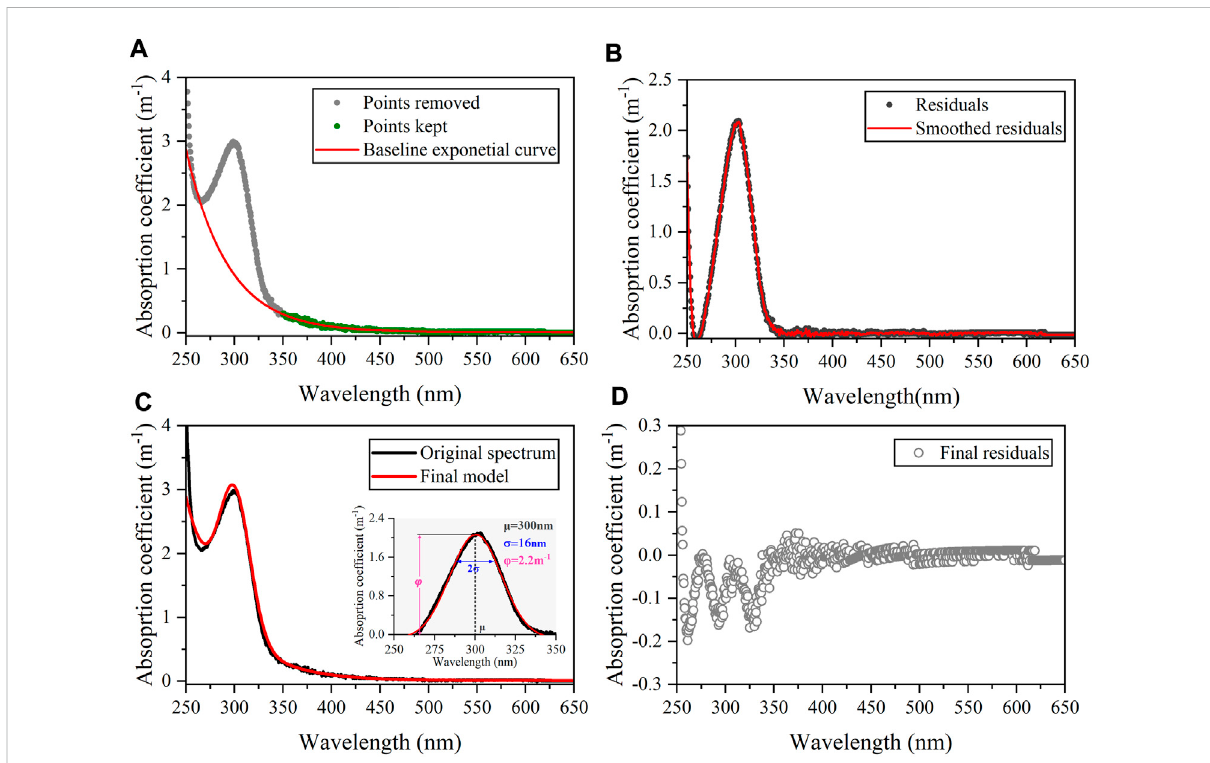
FIGURE 6 Schema of the modeling framework illustrating the fi tting process on groundwater absorption curve using an exponential-Gaussian equation (taking G2 station as an example). (A) Result of the baseline exponential fi tting process. Gray points have been discarded to calculate the baseline exponential curve. (B) Residual plot of the baseline exponential model (observed data – fi tted data). (C) The estimated Gaussian parameters and fi nal exponential-Gaussian model result (D) Final residuals from the estimated spectrum (observed data – fi tted